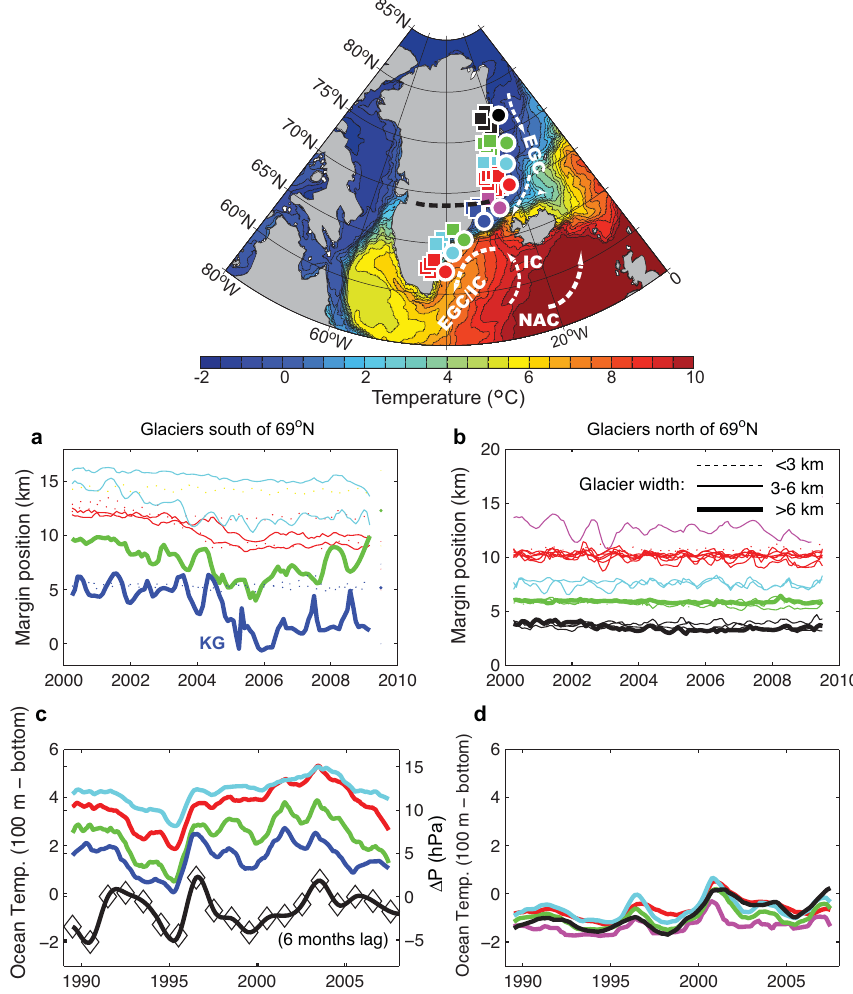
Fig. 11. Map of Greenland and surrounding seas (top) with coloured squares showing locations of marine-terminating glaciers whose frontal positions are shown in (a) and (b) . Coloured dots show adjacent locations where subsurface temperatures are examined in ocean reanalysis (c–d) . The colour scale show sea surface temperature averaged for 2004. EGC, IC and NAC refer to East Greenland Current, Irminger Current and North Atlantic Current. (a) Changes in the position of calving fronts for glaciers south of 69 ◦ N. The colours represent three glaciers in Mogens Fjord (red), Tingmjarmiut and A. P. Bernstoffs Gletscher (cyan); Helheim Glacier (green), and three glaciers in KFj including KG (blue). (b) Same as (a) but for glaciers north of 69 ◦ N. The glaciers are Borggraven (magenta); eight glaciers in Scoresbysund including Daugaard-Jensen (red); Hisingers and Nordenskjorlds Gletscher near Mestervig (cyan); four glaciers in and around Kejser Franz Joseph Fjord (green), and four glaciers near Danmarkshavn (black). Colours match locations shown on map (top). (c) Subsurface temperature from ocean reanalysis averaged from 100m to bottom for sites near glaciers south of 69 ◦ N. Seasonal temperature variations are excluded by filtering the time-series of monthly means with a 12-month-moving average. Colours correspond to those in (a) and locations shown on map (top). Black diamonds and solid black line show winter atmospheric pressure difference across Denmark Strait ( 1 P ) as seen in station records from Tasiilaq and Stykkish´olmur (see Fig. 1 for location and text for details). (d) Same as (c) but temperature is for sites near northern glaciers. Modified from Seale et al.